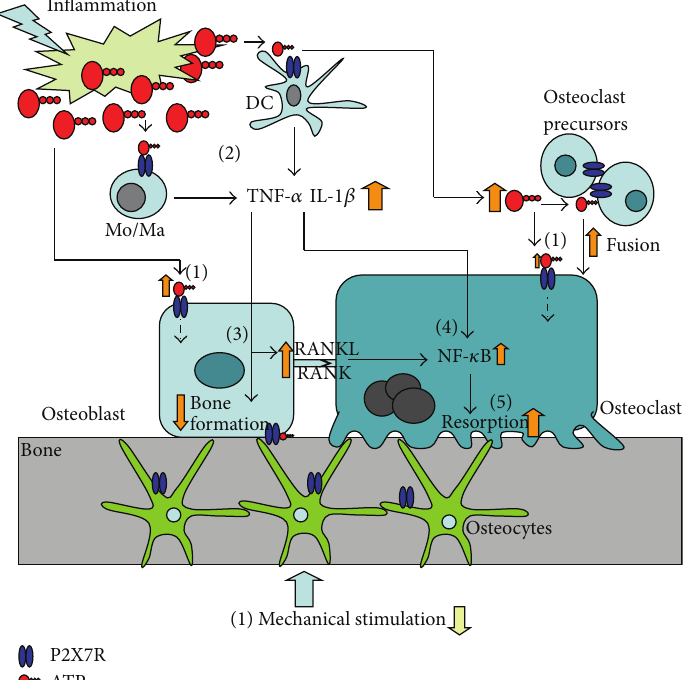
Figure 2: The theoretical involvement of the P2X7 receptor in inflammatory-induced bone loss. The inflammatory process involves release of largeamountsofATPthatactivatesP2X7receptorsonimmunecellsandpossiblyalsoP2X7receptorsonbonecells.(1)P2X7receptorsonbone cells are activated by ATP released from tissue/cell injury at the site of inflammation. (2) P2X7 receptors on monocytes (Mo), macrophages (Ma), and dendritic cells (DC) at the site of inflammation are activated by ATP released from cell/tissue injury. P2X7 receptor activation on these cells induces K + efflux and activation of the NALP3 inflammasome leading to processing and release of proinflammatory cytokines such as interleukin-1 𝛽 (IL-1 𝛽 ) and tumor necrosis factor- 𝛼 (TNF- 𝛼 ). (3) TNF- 𝛼 inhibits osteoblastic function (reduces bone formation